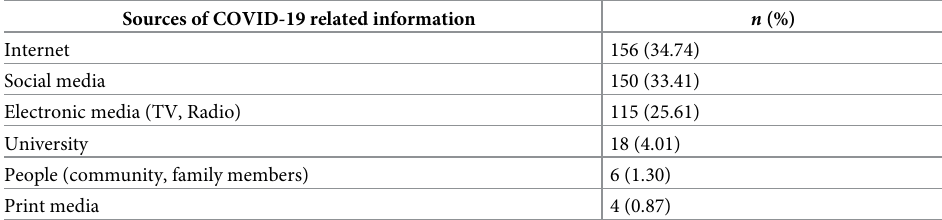
Table 2. Most used sources of COVID-19 related information. Sources of COVID-19 related information n (%)